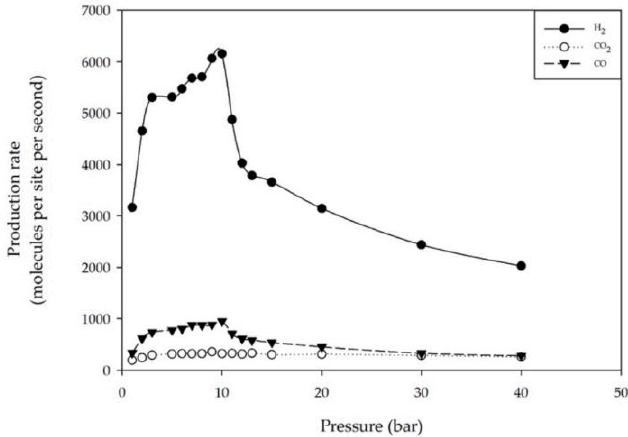
Figure 2. Production rate as function of the total pressure, T = 550 °C and yCH 4 = 0.5 [67].